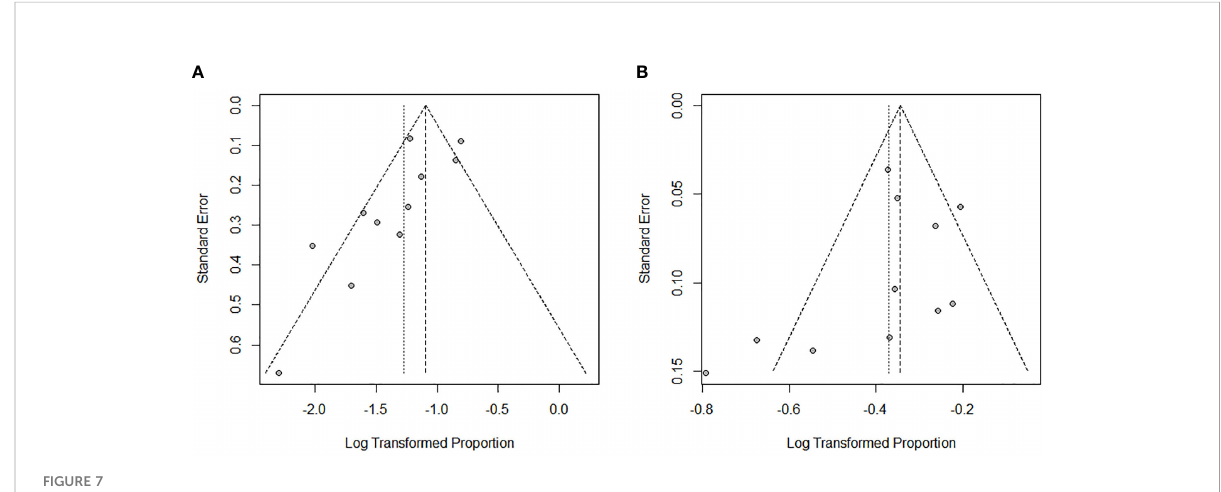
FIGURE 7 Egger funnel plot of ORR (A) and DCR (B)